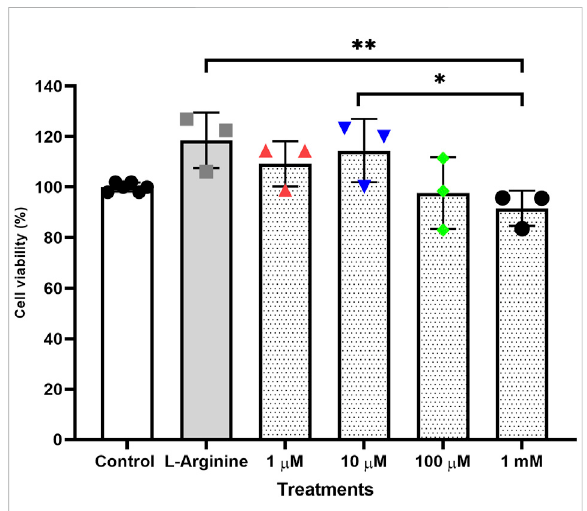
Cell viability of the thymus-derived endothelial cell line tEnd.1after treatment withL-arginine(100 µM)andL-NAME (1,10, 100 μ M, 1 mM) for 72 h without retreatment. Data were compared by Two-way ANOVA, followed by Tukey ’ s test. (*Represents statistically signi fi cant difference between groups for p < 0.05; **Representsstatisticallysigni fi cantdifferencebetweengroupsfor p <